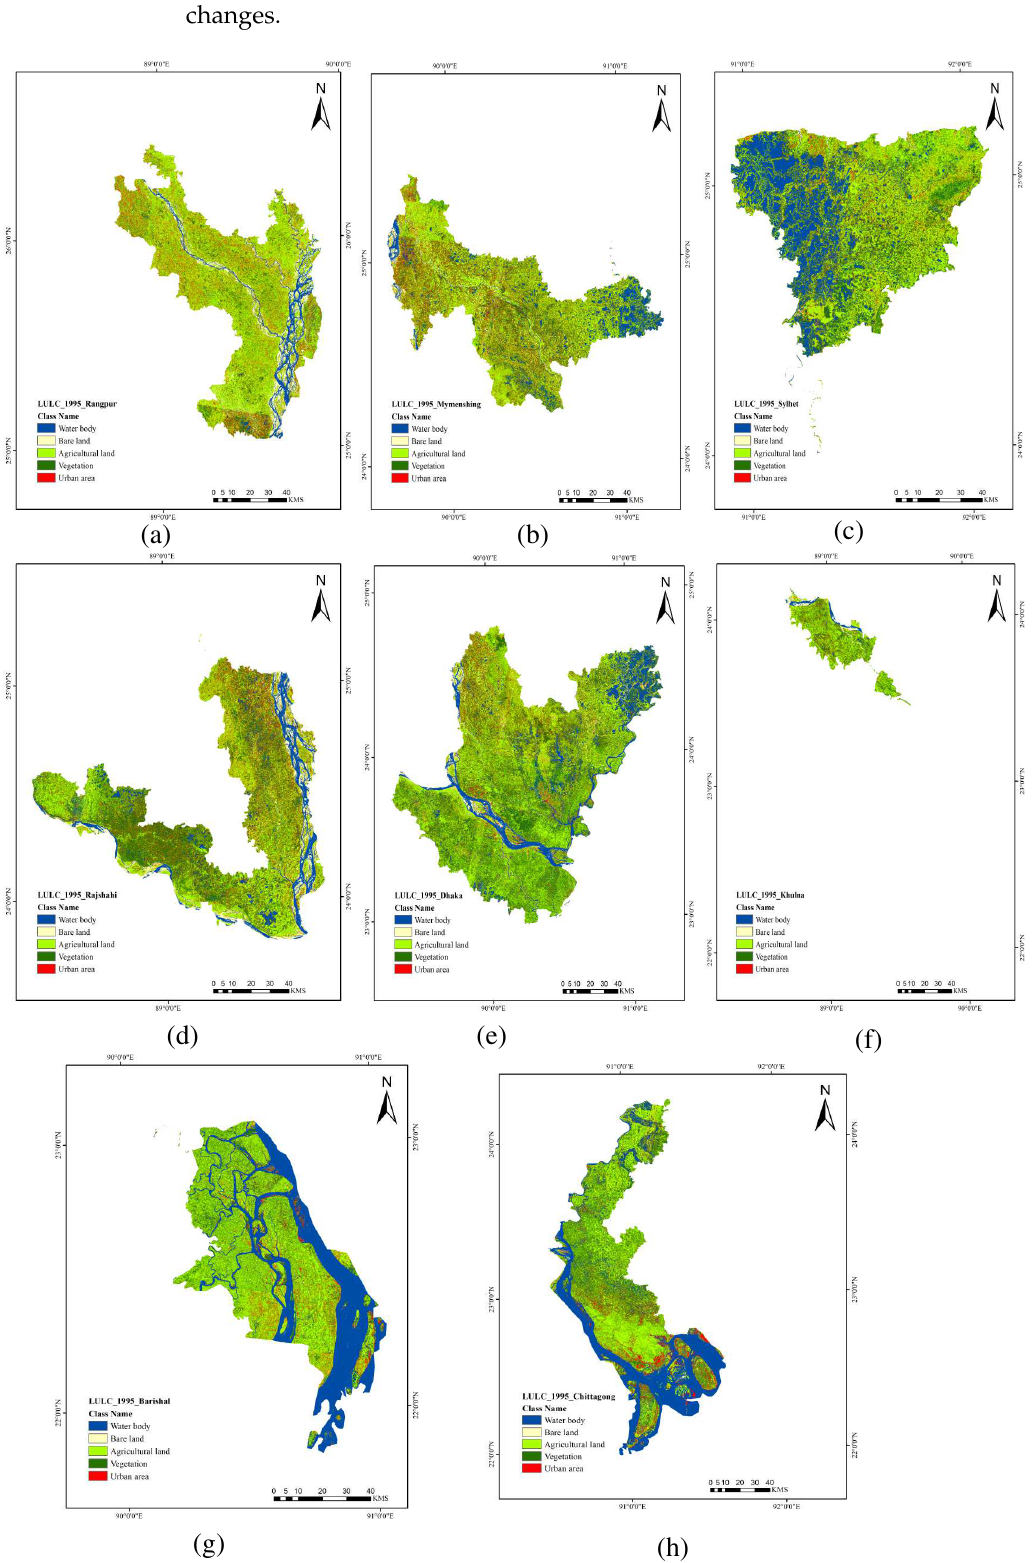
Figure 6. LULC maps for all administrative divisions of Bangladesh for 1995; ( a ) Rangpur; ( b ) My- mensingh; ( c ) Sylhet; ( d ) Rajshahi; ( e ) Dhaka; ( f ) Khulna; ( g ) Barishal and ( h ) Chittagong.